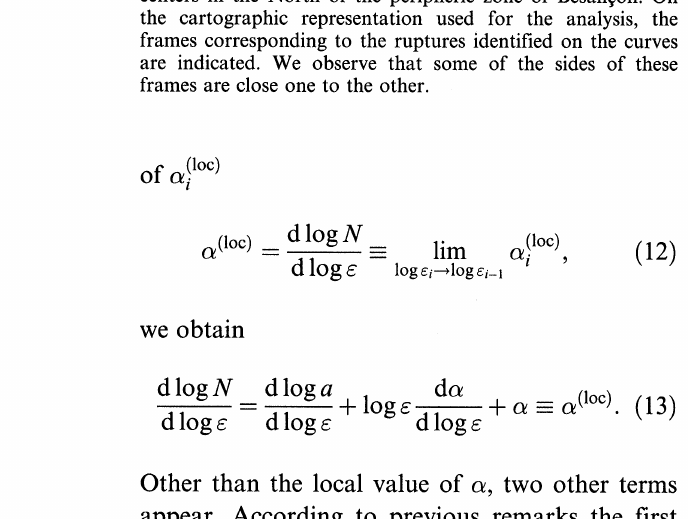
FIGURE 6 The smoothed curves referring to two counting centers in the North of the peripheric zone of Besangon. On the cartographic representation used for the analysis, the frames corresponding to the ruptures identified on the curves are indicated. We observe that some of the sides of these frames are close one to the